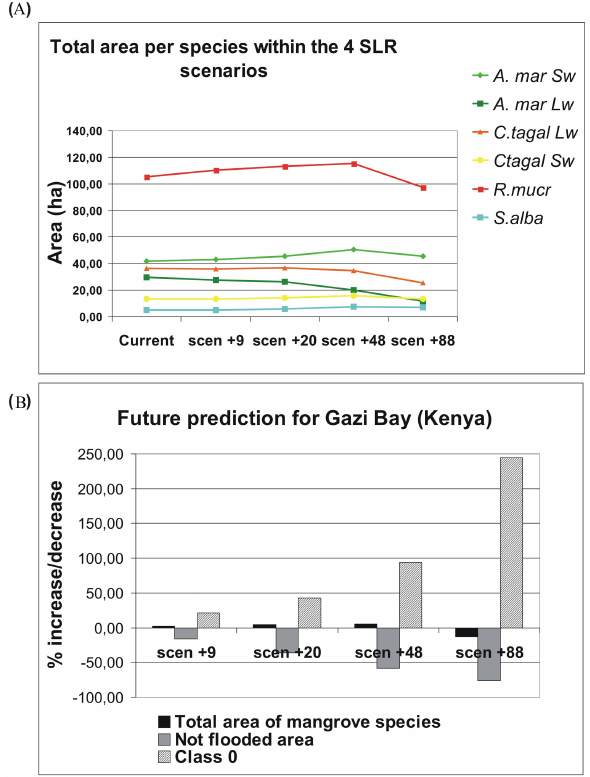
Fig. 3. (A) Graph of the total area (ha) per species within the four SLR scenarios, (B) future prediction of the dynamics of man- groves, non-flooded area and class